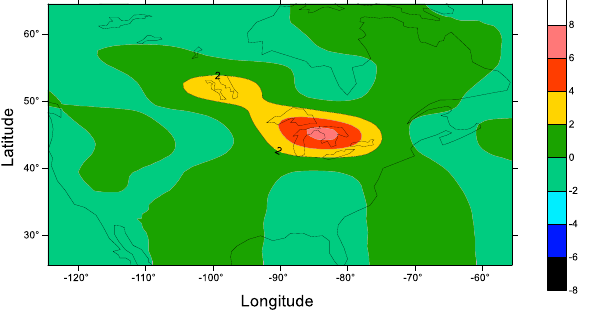
Figure 6. Mascon solution for the trend rates of the separated TWS changes in North America (x10 -3 m /yr.)